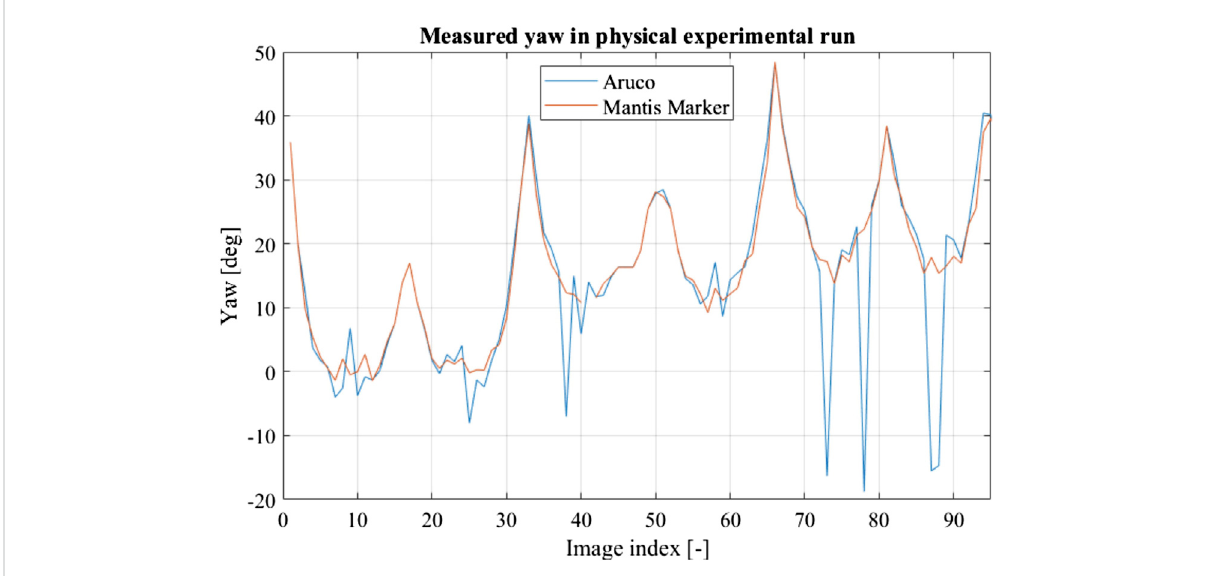
FIGURE 12 Result of validation experimental run using a robotic arm. The ArUco marker without encoding element shows both loss of precision in frontal observations and pose ambiguity, similar to the created virtual